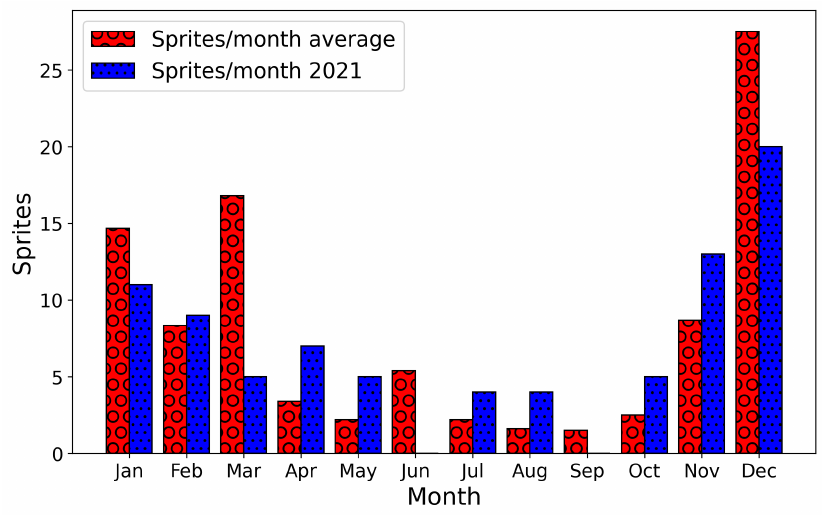
Figure 1. Distribution of the monthly number of sprites observed by ASCA. The red bars show the monthly averaged number of observed sprites from September 2016 to February 2022, and the blue bars show the monthly number of observed sprites in